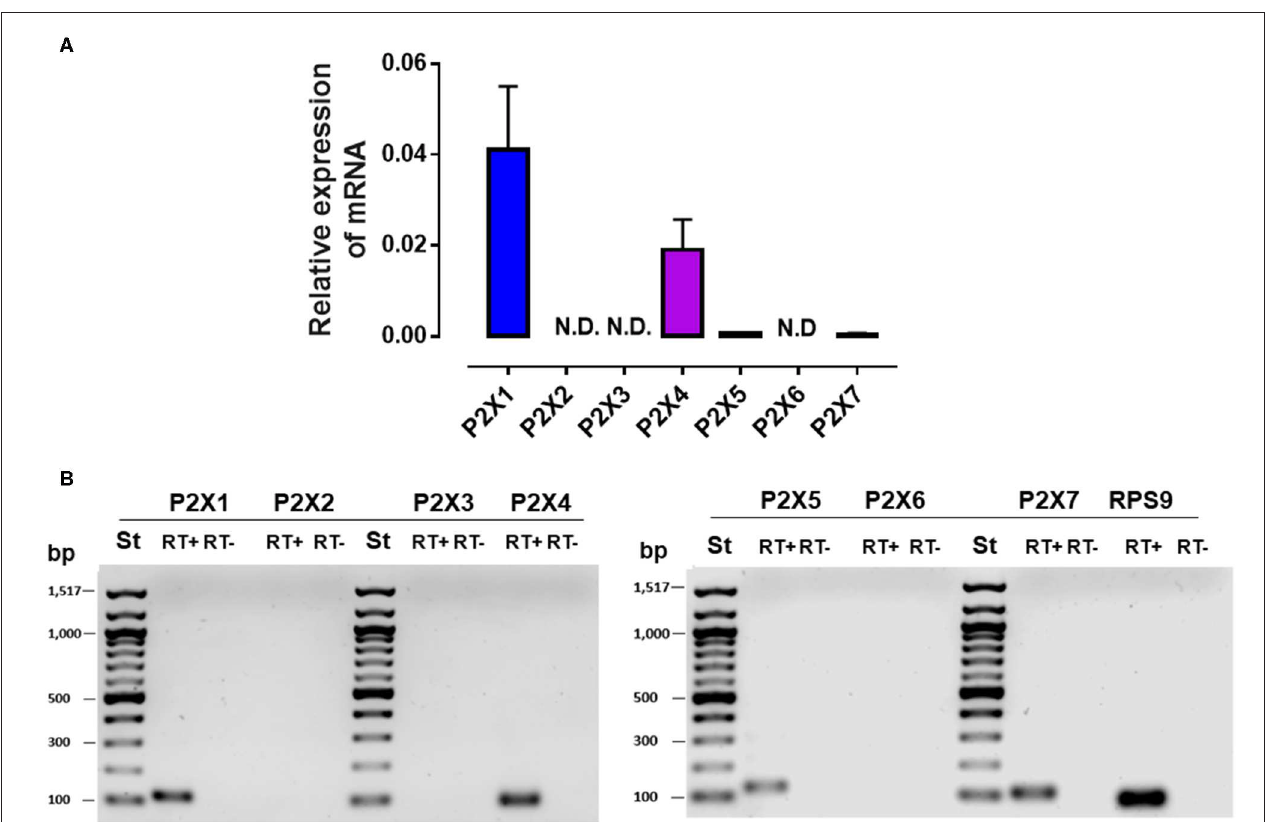
FIGURE 5 | mRNA expression of the P2X receptor in bovine PMN. Relative expression of P2X1 – 7 to RPS9 (housekeeping) in bovine PMN (A) . Representative image of PCR amplicons of P2X receptors (B) . N.D., not detected.; bp, base pair; ST, standard of bp; RT + , RT–, reverse transcriptase + , reverse transcriptase –. N = 4.